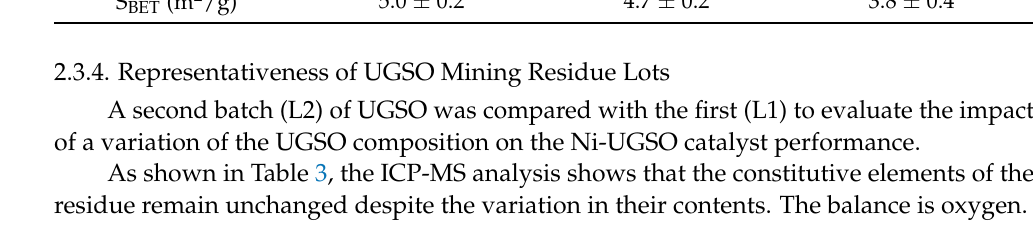
Table 3. ICP-MS analysis of two batches of UGSO